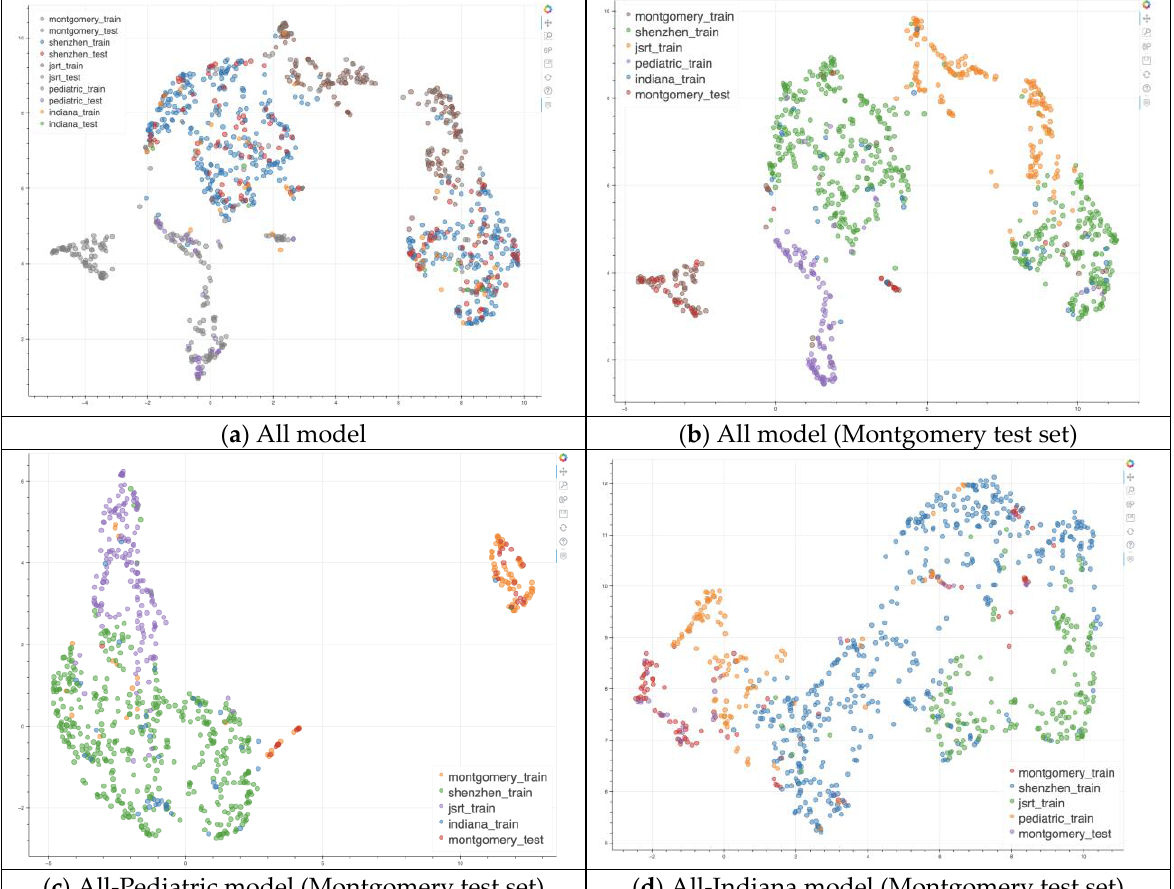
Figure A3. UMAP of YOLOv5 features extracted from the All model.